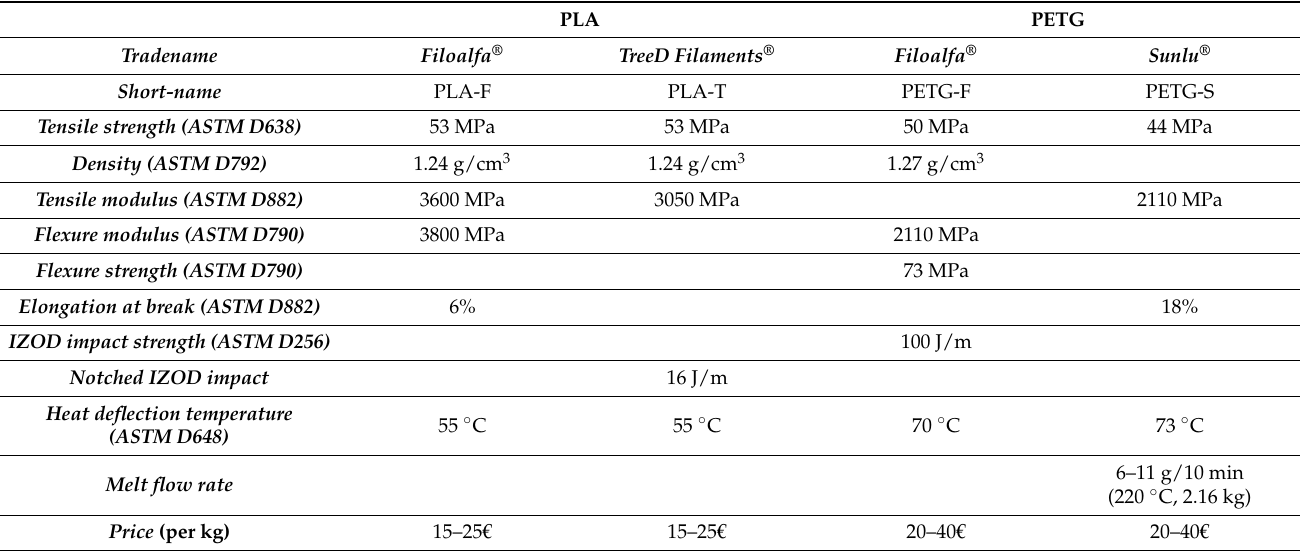
Table 1. Properties of the considered polymers using data from the database CES EduPack (Granta Design, UK) and filament datasheets. PLA